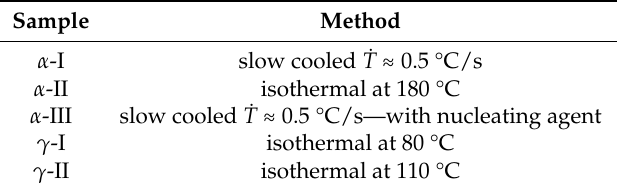
Table 1. Cooling